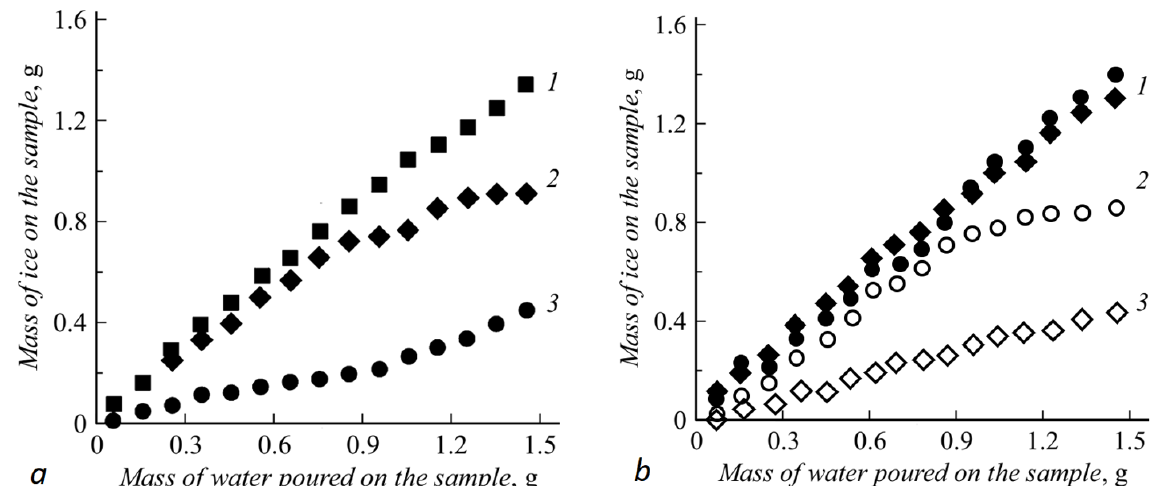
Figure 3. Dependence of the icing mass of the sample on the mass of poured water: ( a ) the temperature equals − 10 ◦ C; ( b ) the temperature equals − 30 ◦ C. Empty shapes mean that the heating layer is working, filled in shapes show that there is no heating. Squares—a steel sample with no coating; rhombi—a coating with a hydrophobic layer, obtained by sputtering; circles—a coating with a hydrophobic layer, obtained by gluing ground xerogel.